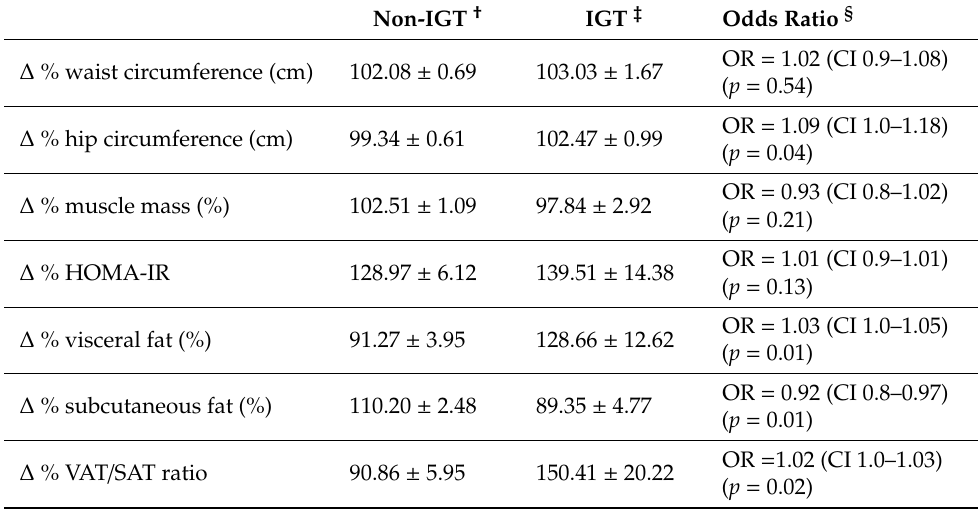
Table 4. Descriptive statistics, odds ratios, and corresponding p -values in the prospective study estimated using age-adjusted generalized linear models with the logit link